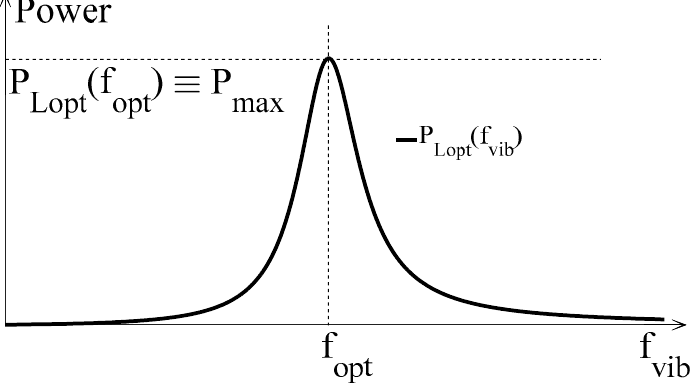
Figure 5. Typical shape of the power extracted by a RVEH (P-RVEH or E-RVEH), when loaded with the optimal impedance as a function of the vibration frequency.